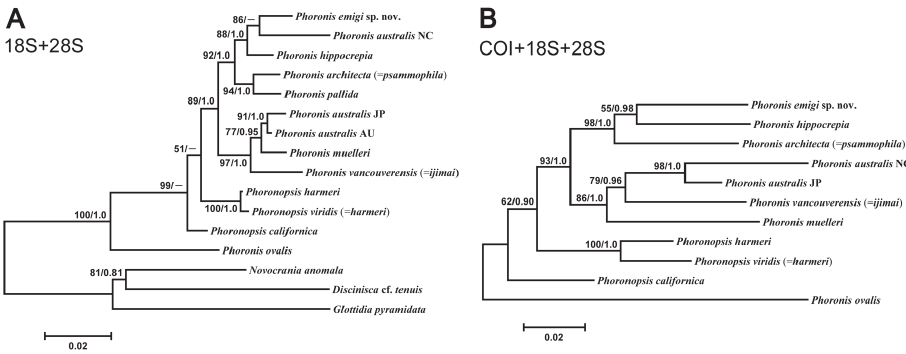
Figure 14. A Maximum-likelihood tree for 13 phoronid samples based on the combined 18S + 28S data set; three brachiopod species ( Novocrania anomala , Discinisca cf. tenuis , and Glottidia pyramidata ) are included as outgroup taxa B maximum-likelihood tree for 11 phoronid samples based on the combined COI + 18S + 28S data set; the tree is rooted with P. ovalis . Scale bars indicate branch length in substitu- tions per site. Nodal support values are presented as the ML bootstrap value followed by the Bayesian posterior probability; only values >50% and 0.50, respectively, are